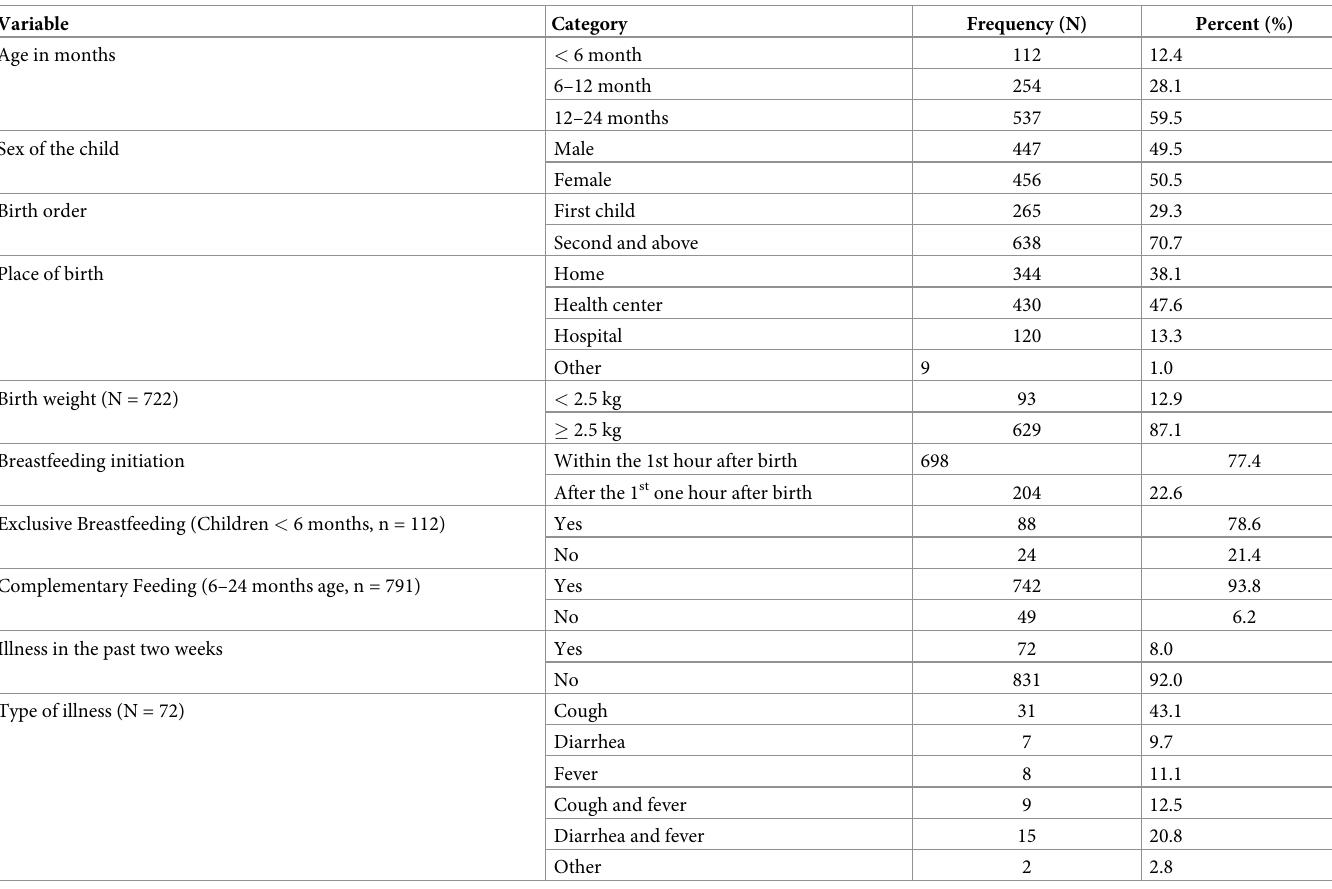
Table 2. Child characteristics and young child feeding practices in Dale district, Ethiopia, 2018, categorical variables (n = 903, except where otherwise indicated). Variable Category Frequency (N) Age in